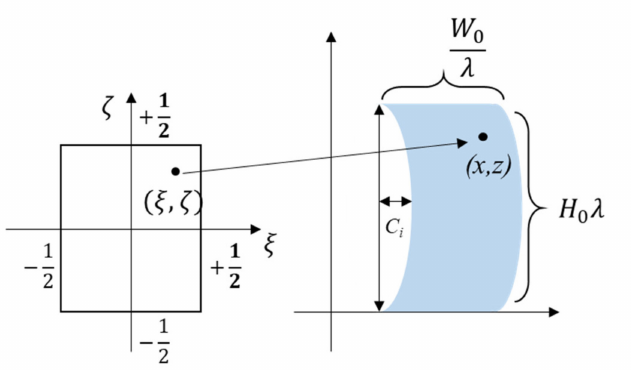
Figure 8. Material coordinate and spatial coordination to describe the block motion and deforma- tion [13].